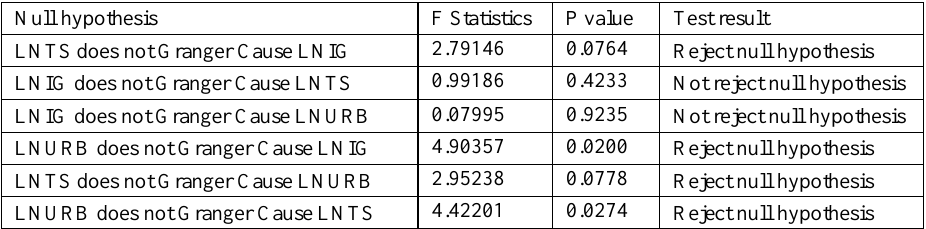
Table 2. Granger causality test of three variables of LnURB, LnTS and LnIG.